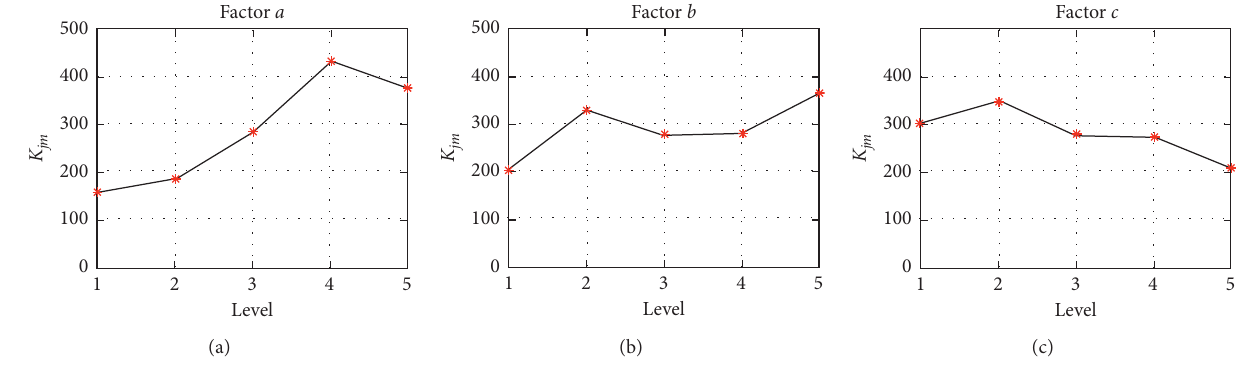
Figure 13: The level and K jm trend diagrams of each factor. (a) Factor a . (b) Factor b . (c) Factor c.